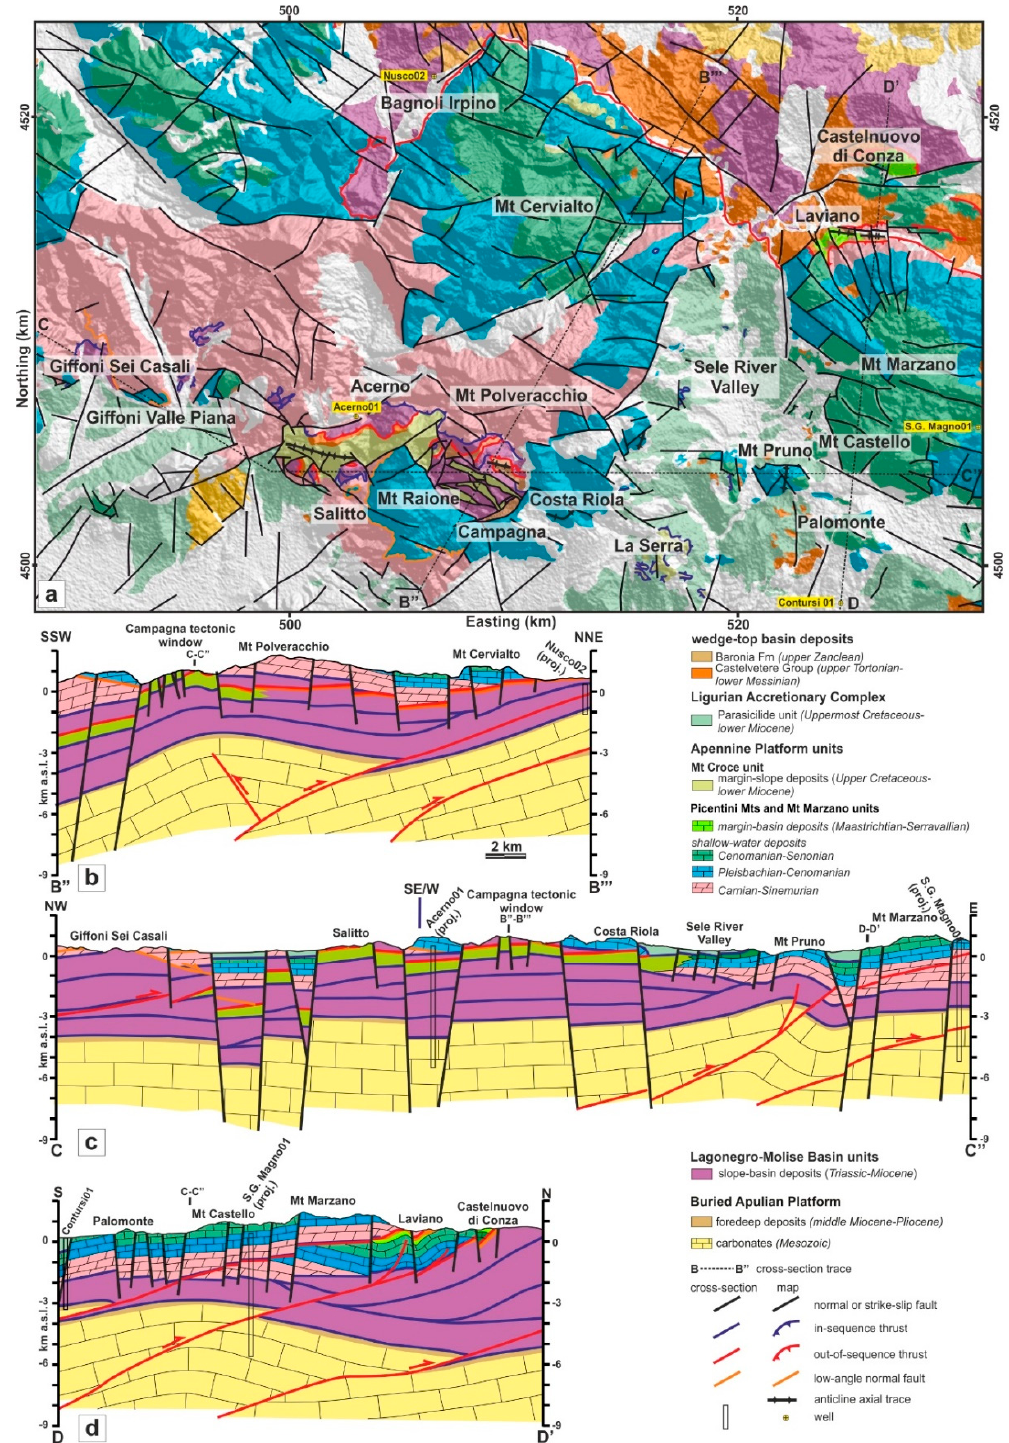
Figure 13. ( a ) Geological map of the Giffoni and Campagna tectonic windows, Picentini Mts, Sele River Valley, and Mt Marzano (modified after [8]). ( b – d ) Geological cross-sections. The C-C” cross-section (Figure 13c) runs through the two tectonic windows up to the Sele River Valley. In our interpretation, the out-of-sequence thrust exposed in the Campagna tectonic window is dipping to the west, forming a frontal anticline in the hanging wall (Costa Riola fold, Figure 13a) bounding the western side of the Sele River Valley. Furthermore, another thrust fault in the